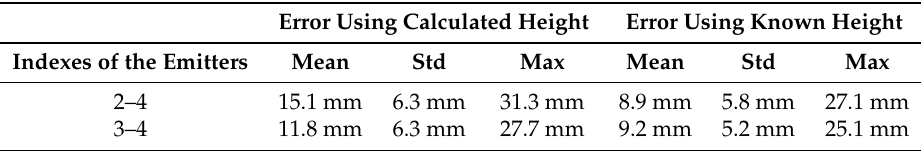
Table 3. Positioning error using two emitters.